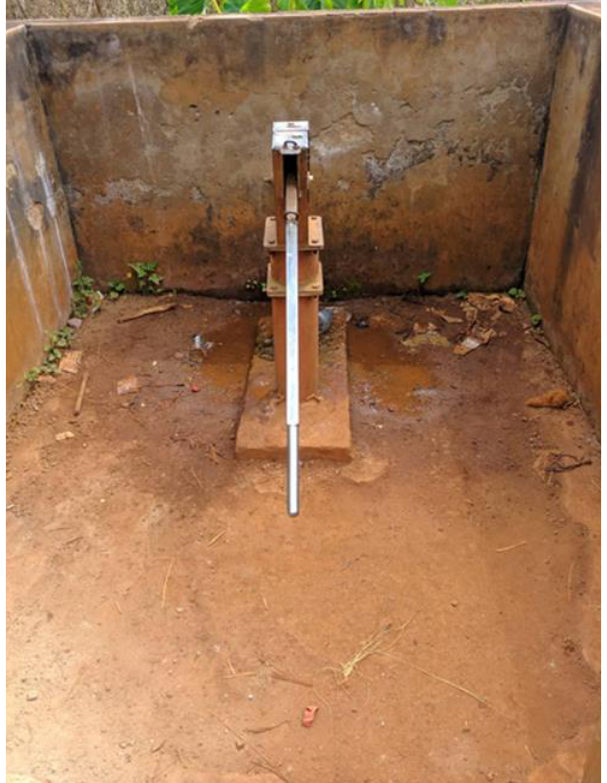
Figure 8. The single functional public borehole in Feutap 1 ‘Cogefar’. Own photograph, 9 January